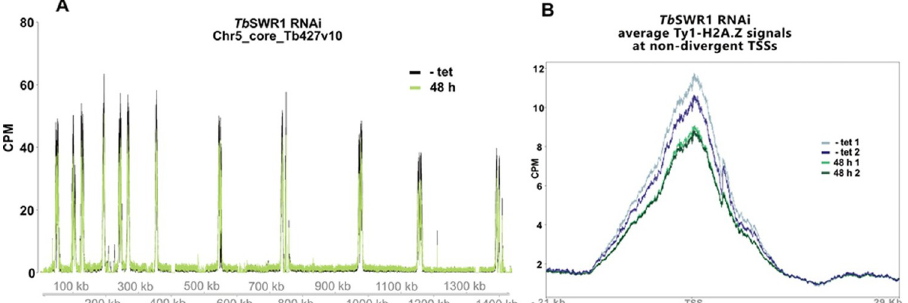
Fig 3. Loss of Tb SWR1 (Tb927.11.10730) leads to a reduced H2A.Z deposition at TSS. (A) ChIP-Seq analysis of distribution of Ty1-tagged H2A.Z before (black) and after (green) RNAi-mediated depletion of Tb SWR1 (48h post induction) revealed a reduction of chromatin associated Ty1-H2A.Z. Depicted is a representative region of chromosome 5. Data (n = 2) were normalised to the total number of reads and plotted as counts per million reads (CPM). (B) Average Ty1-H2A.Z signal across non-divergent TSSs. Peaks derived from two non-tetracycline induced reference samples depicted in blue and black. Peaks derived from two samples after 48 h of RNAi-mediated depletion of Tb SWR1 depicted in green and